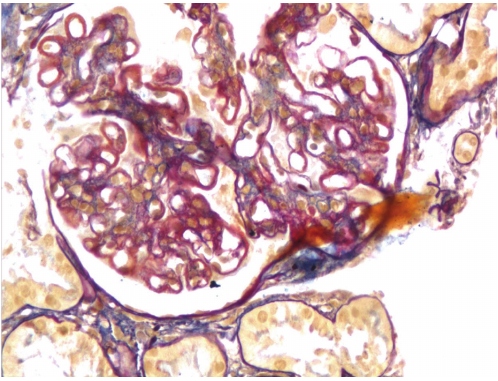
Figure 3: Mononuclear cell infilteration with sclerosed, hyalinised glomeruli indicating chronic disease.